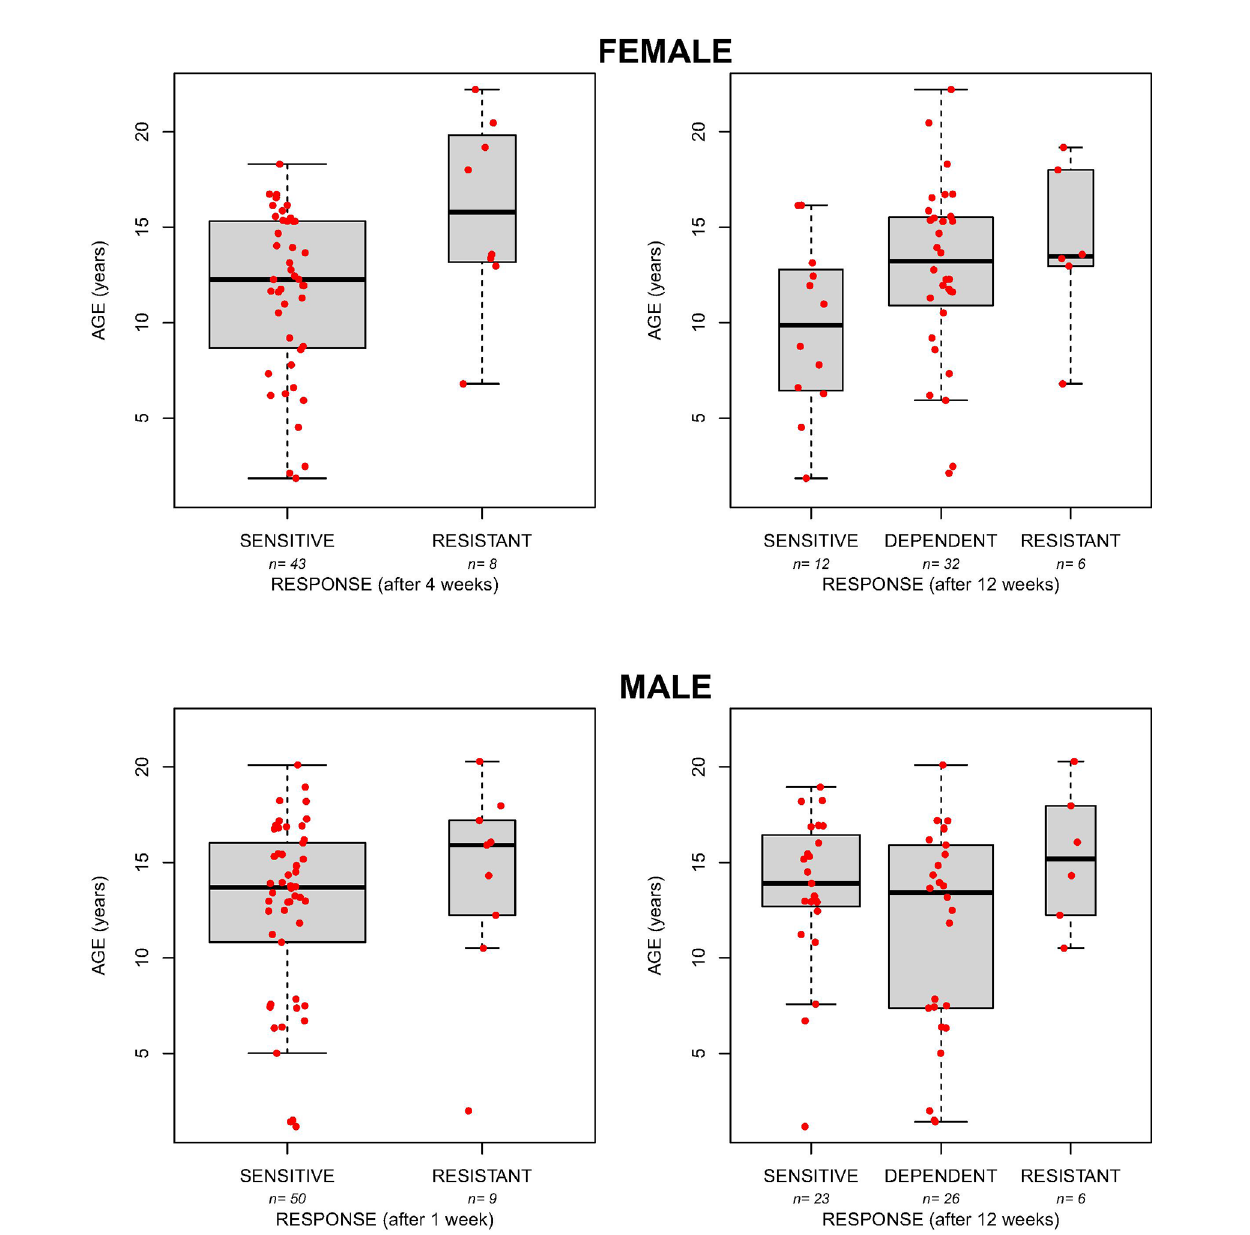
FIGURE 2 | The boxplots show the age in female and male patients sensitive, resistant or dependent to GC after 4 and 12 weeks of